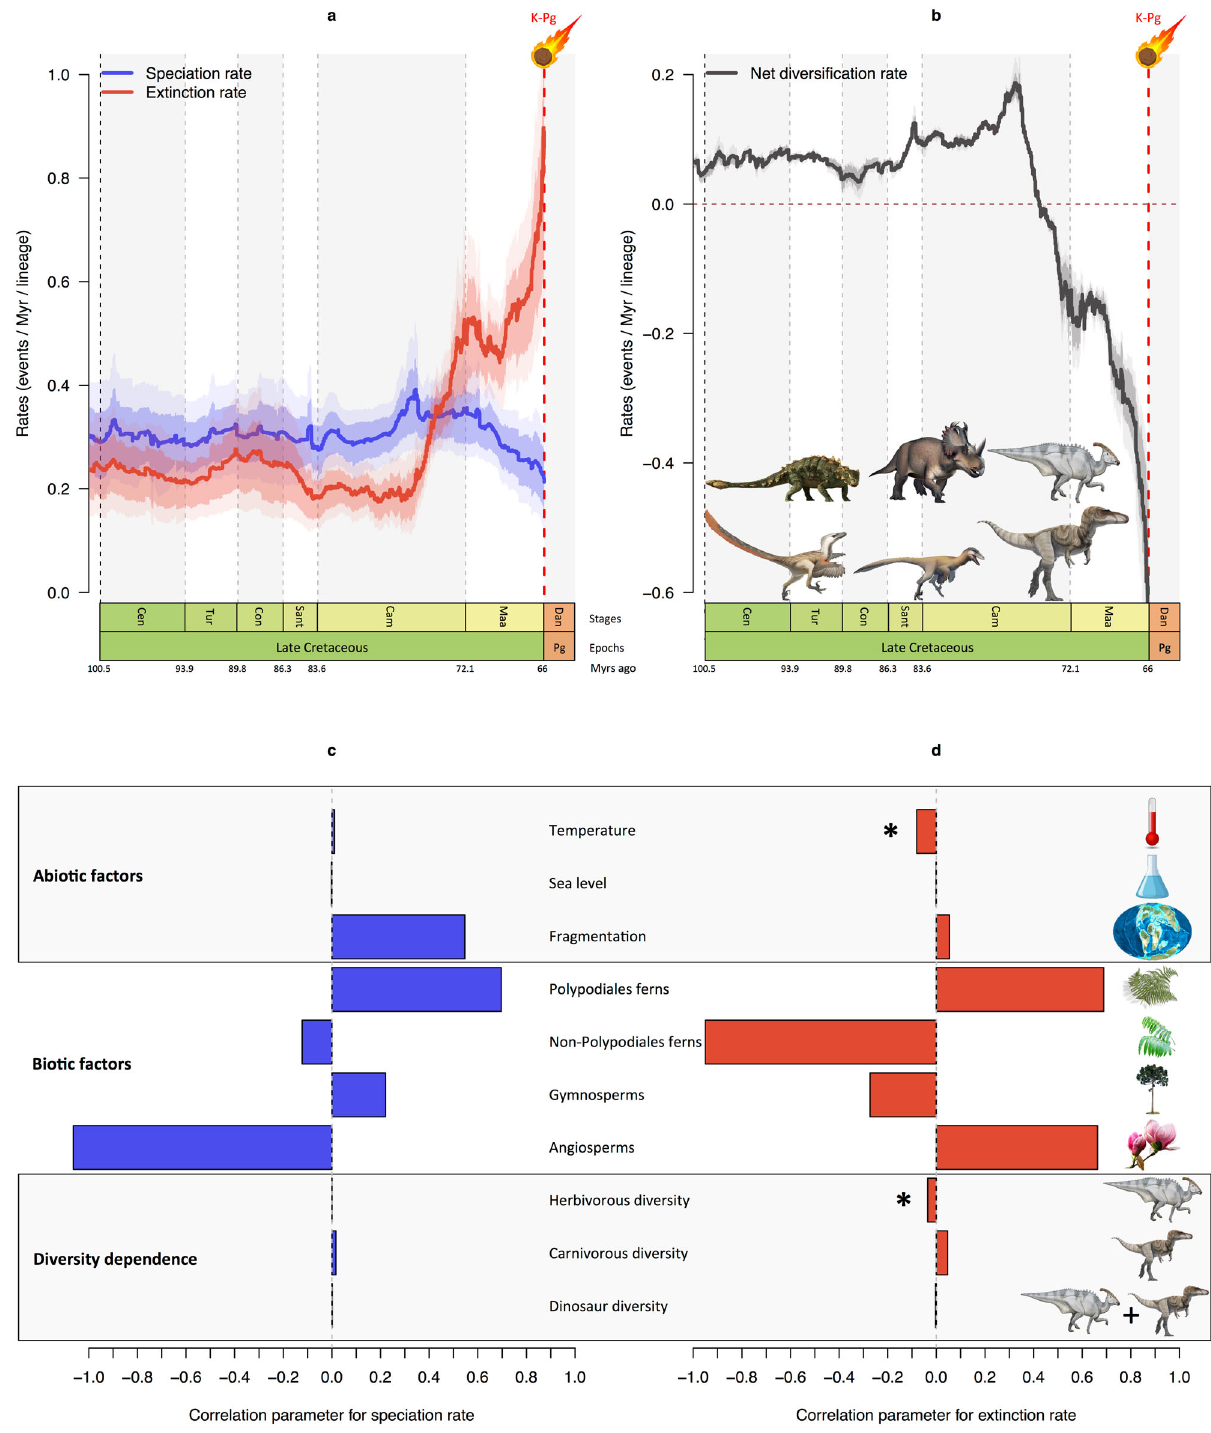
Fig. 4 Past environmental changes and diversi fi cation dynamics of Late Cretaceous dinosaurs. a Dynamics of speciation and extinction rates through time as estimated with the Bayesian multivariate birth – death model in PyRate, while incorporating the effect of putative factors. b Dynamic of the net diversi fi cation rate through time. Solid lines indicate mean posterior rates, whereas the shaded areas show 95% CI. c , d Bayesian inferences of correlation parameters on speciation and extinction with abiotic factors like global temperature, global sea-level fl uctuations, and global continental fragmentation; with biotic factors like the relative diversity through time of Polypodiales ferns, non-Polypodiales ferns, gymnosperms, and angiosperms; and diversity- dependence factors with the diversity through time of herbivorous, carnivorous, and all dinosaurs. The asterisk (*) indicates signi fi cant correlation parameter for a given variable (shrinkage weights ( ω ) > 0.5). Abbreviations as in Fig. 1. Dinosaur pictures courtesy of Fred Wierum (© Wikimedia Commons), Debivort (© Wikimedia Commons), Jack Mayer Wood (© Wikimedia Commons): https://creativecommons.org/licenses/by-sa/4.0/. Palaeomap used with permission © 2020 Colorado Plateau Geosystems Inc. Asteroid, plant pictures and other items made by Fabien Condamine.